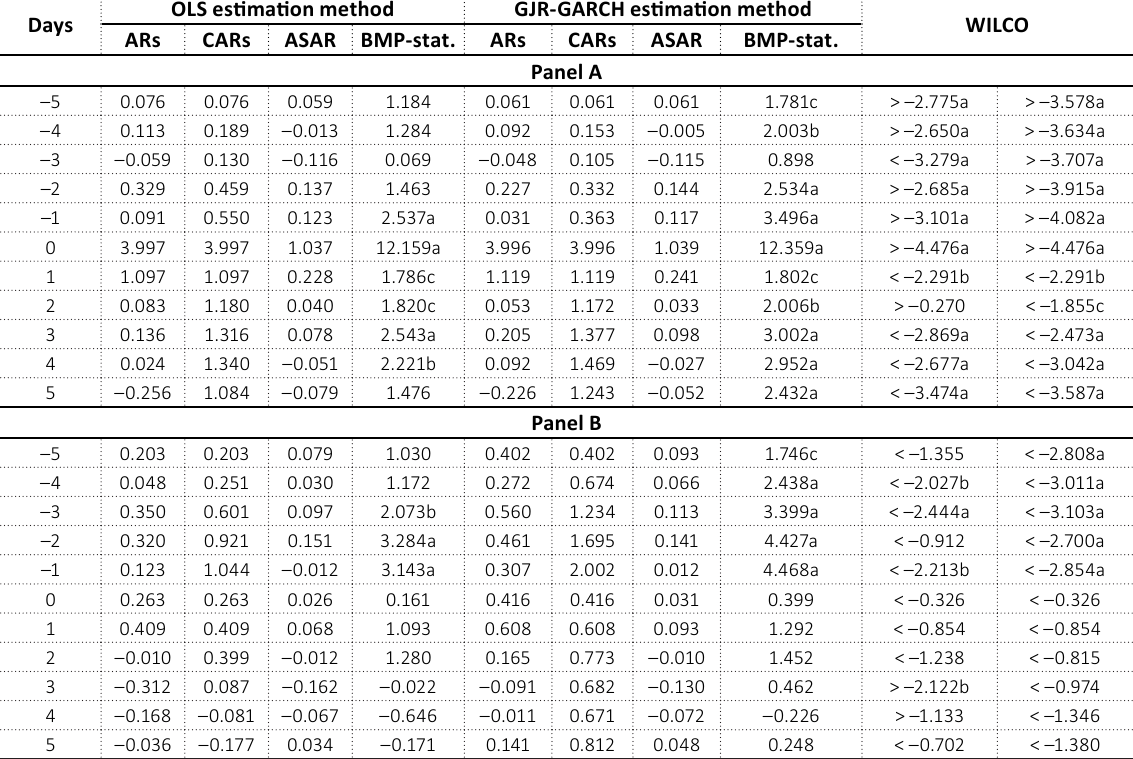
Table 2. ARs and CARs measure for target and acquirer firms around mergers announcements using the four-factor CAPM under the OLS estimation method and the GJR-GARCH estimation method OLS estimation method GJR-GARCH estimation method Days